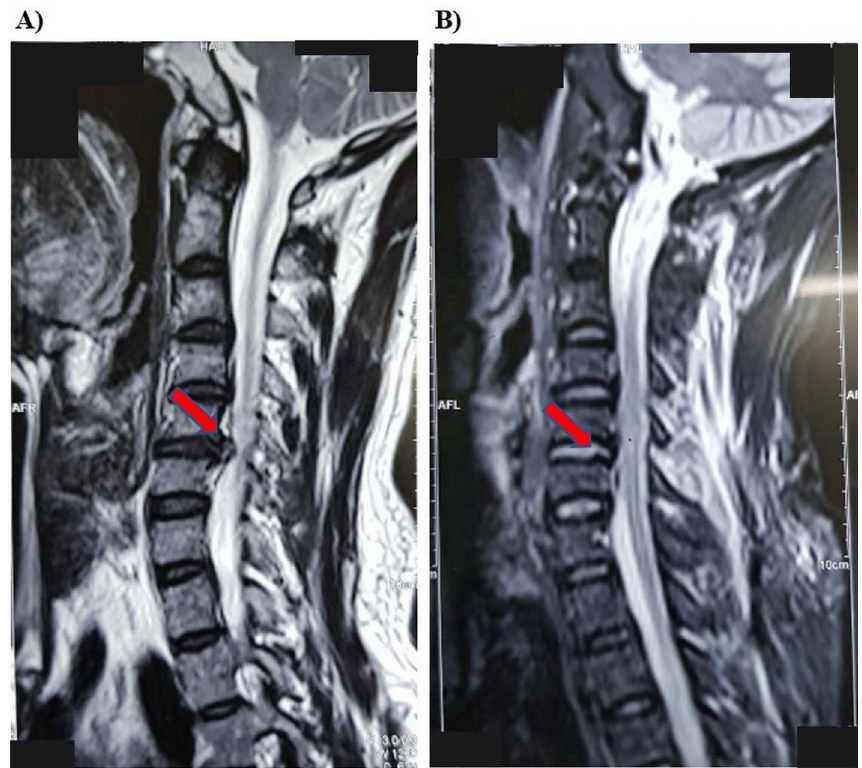
Figure 9. Herniation of C5-6 right. Before ( A ) and after ( B ) operation (male, 32 years old).